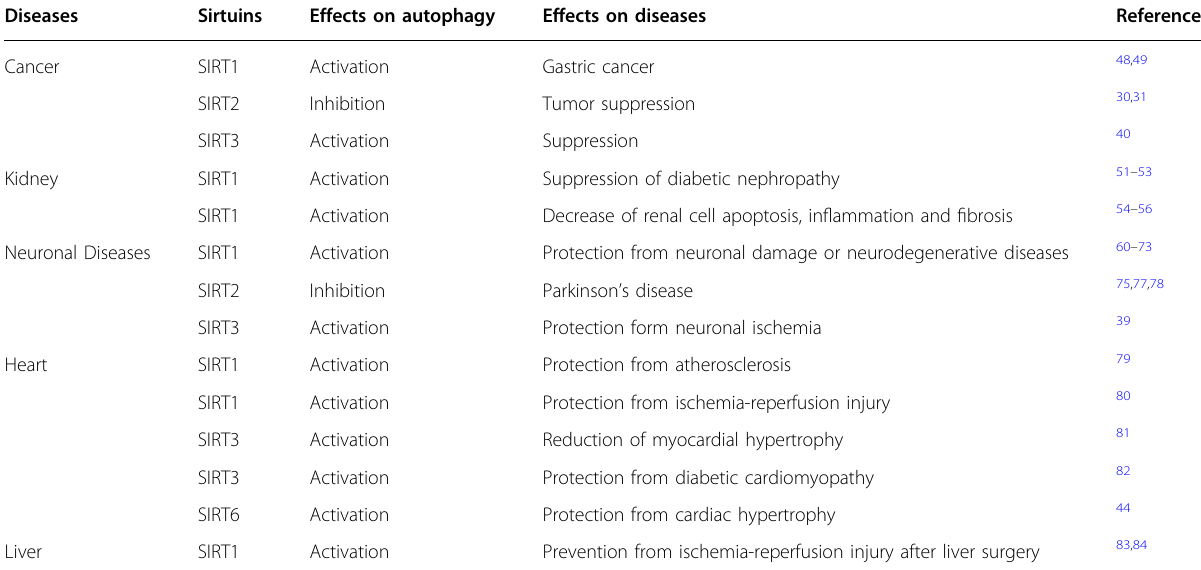
Table 1 The pathophysiological importance of mammalian sirtuins-mediated autophagy Diseases